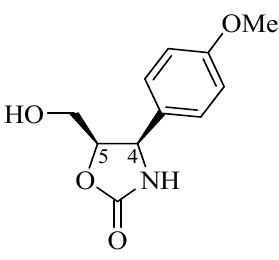
Figure 4. Structure of ( − )-cytoxazone.